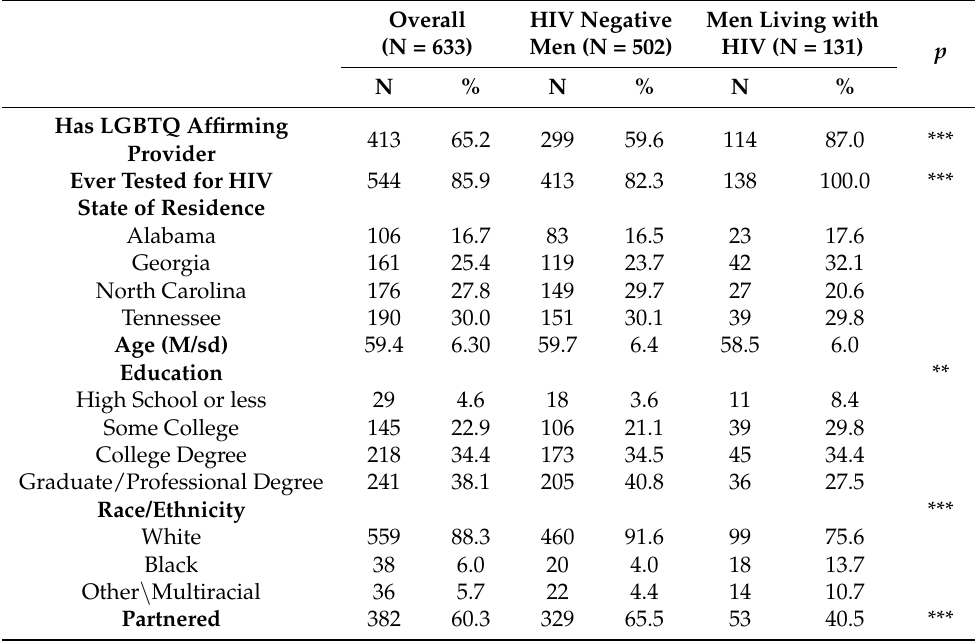
Table 1. Characteristics of older gay and bisexual men in the US south by HIV status, VUSNAPS.